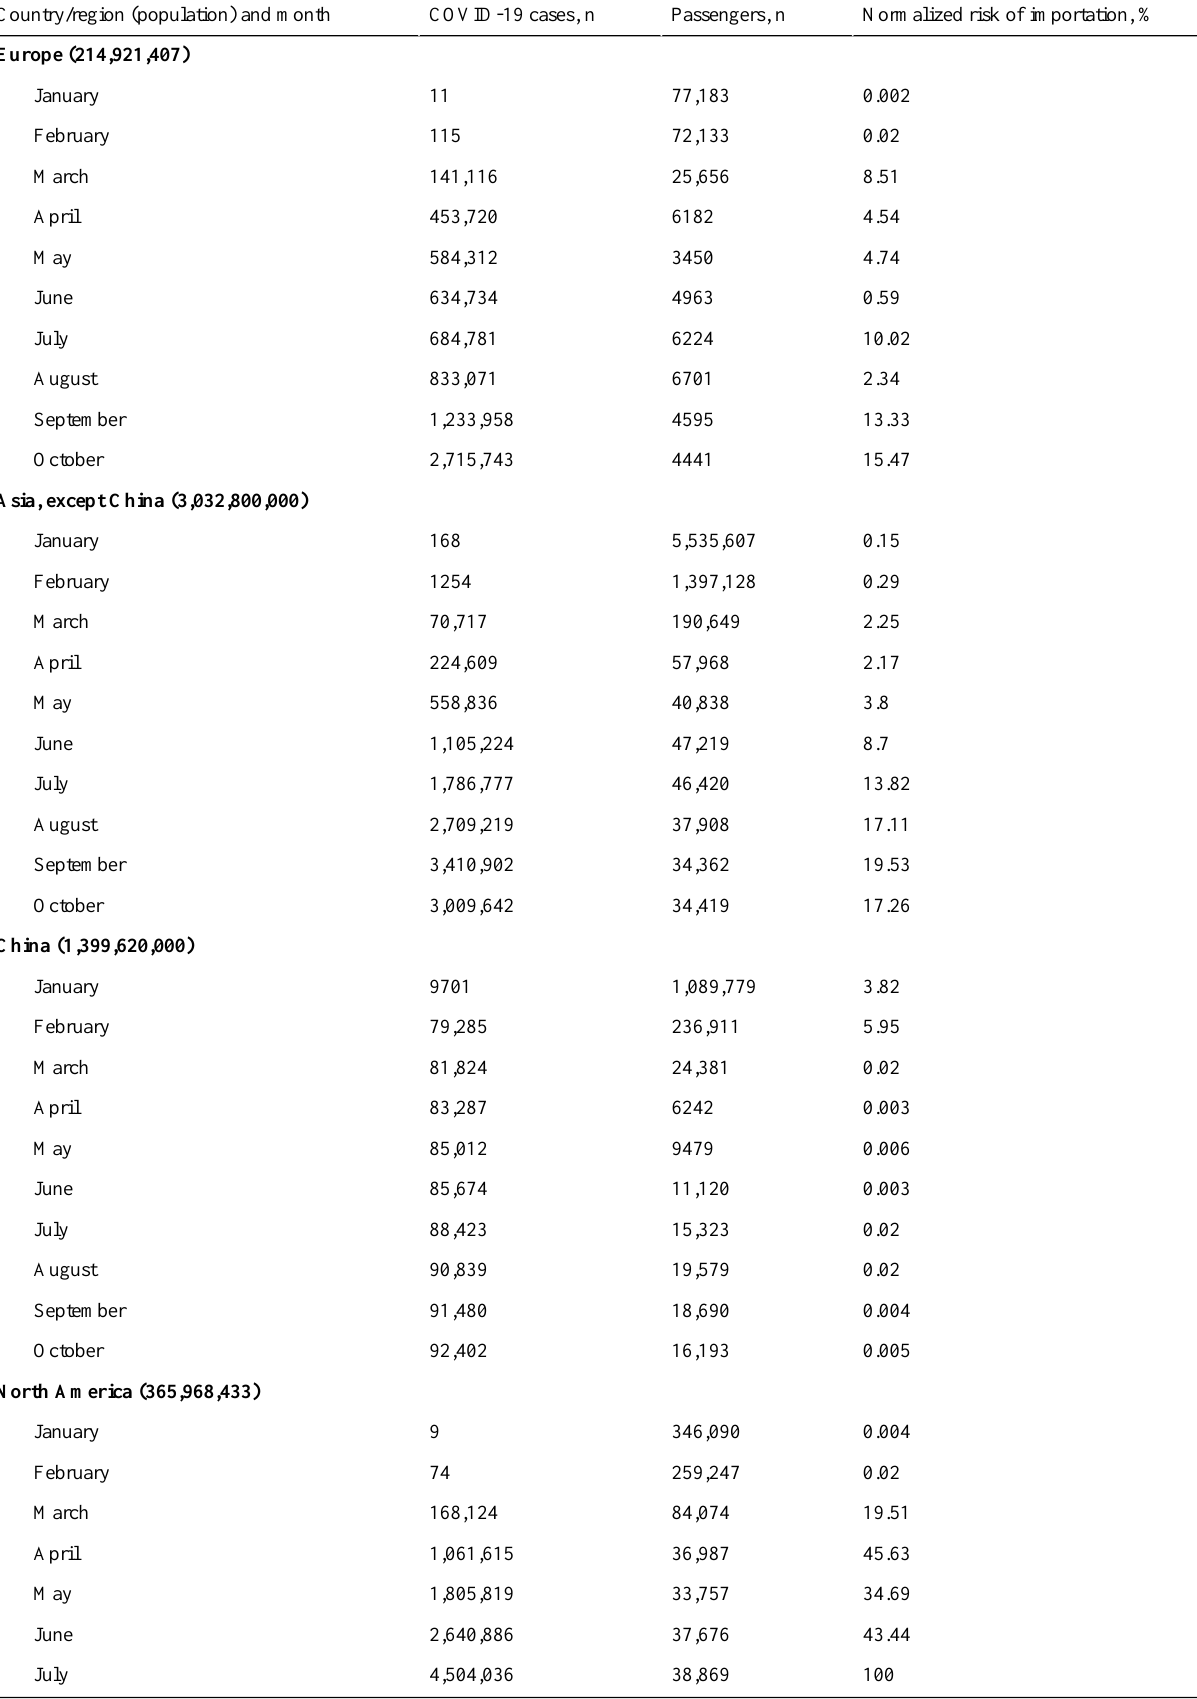
Table 1. Normalized risk of importation in South Korea by country using data on population, number of COVID-19 cases, and number of passengers from January to October in